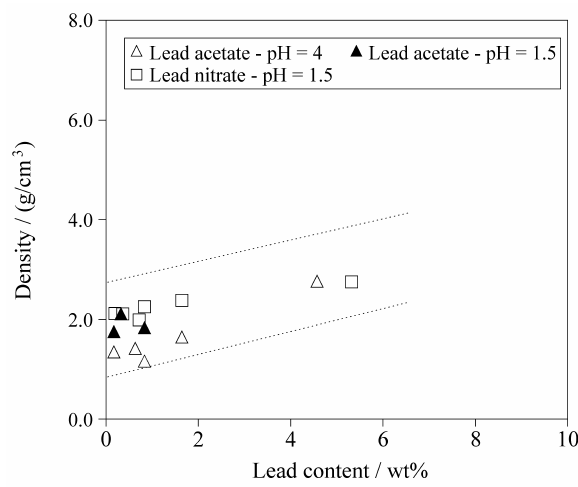
Figure 1. Bulk density as a function of lead content.